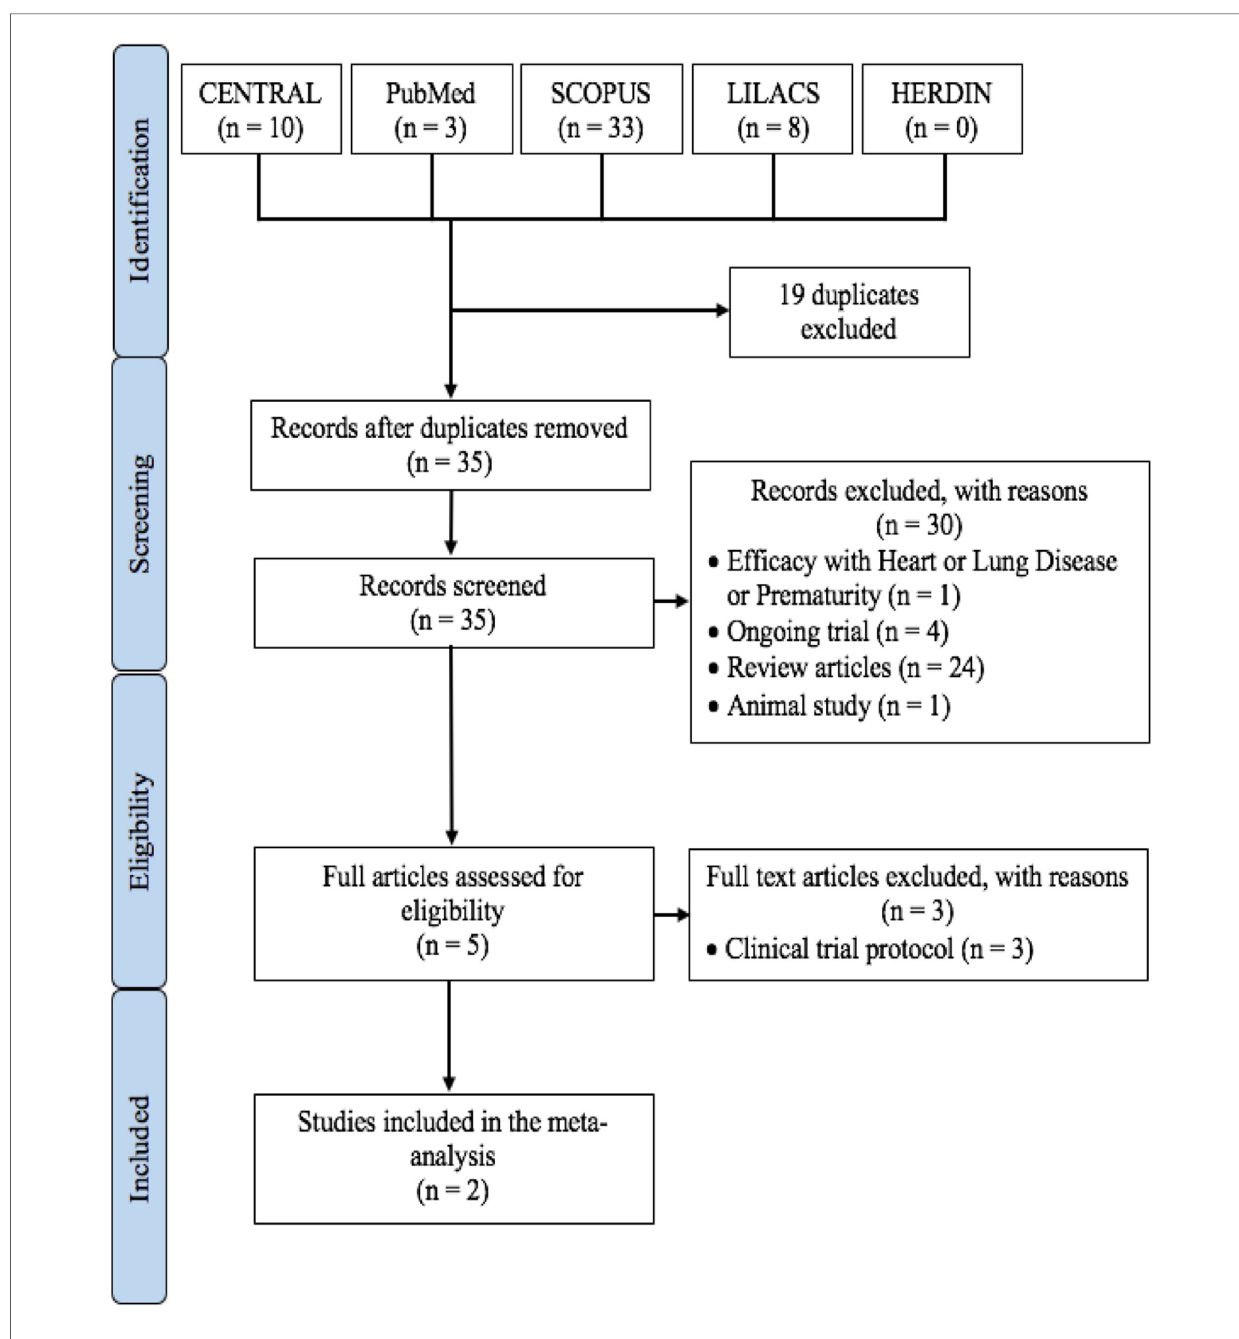
FIGURE 1 PRISMA summary of literature